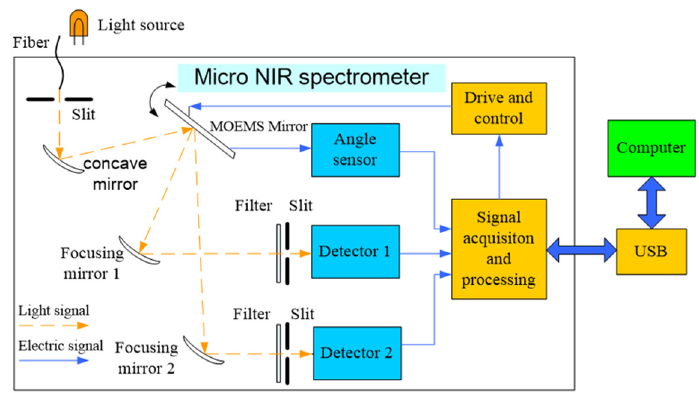
Figure 1. System structure principle of a micro-NIR spectrometer.